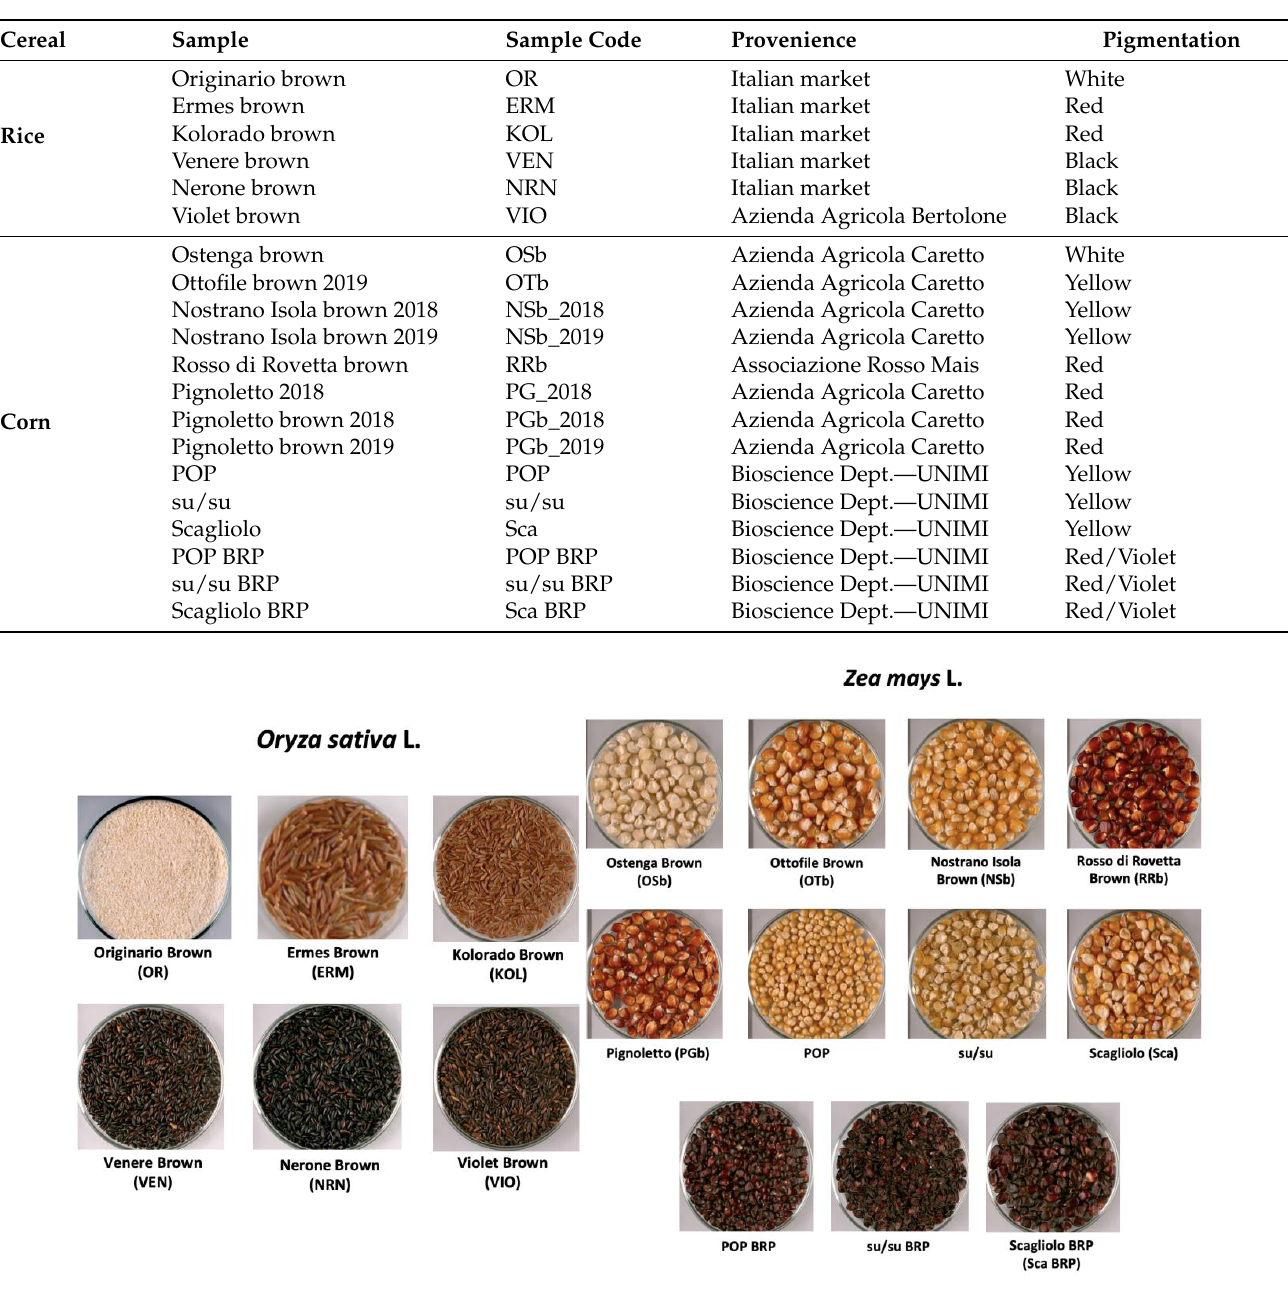
Table 6. Rice and corn samples included in the study.